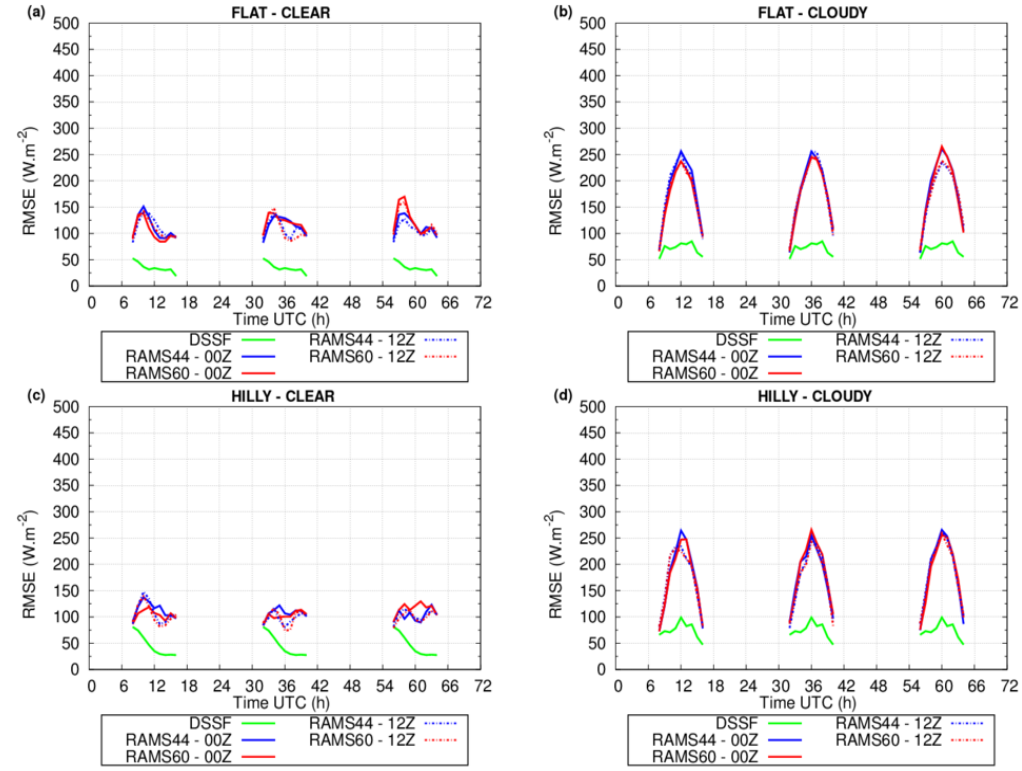
Figure 9. Same as Figure 7, but for the RMSE (W·m − 2 ) statistical score: flat-clear ( a ); flat-cloudy ( b ); hilly-clear ( c ) and hilly-cloudy ( d ). Remote Sens. 2016 , 8 , 46